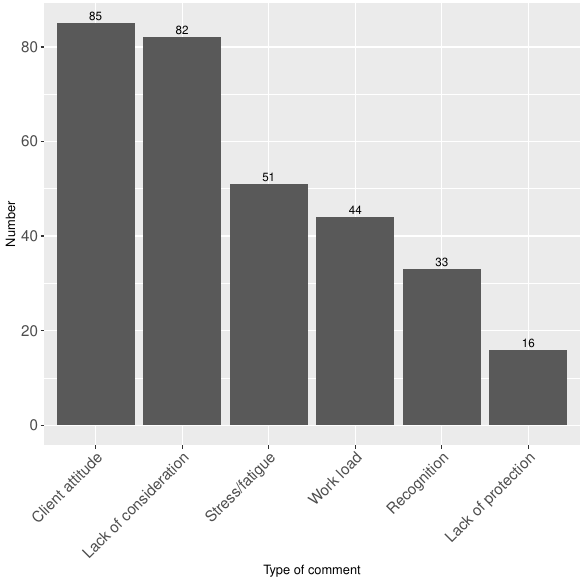
Figure 4. Analysis of free comments by employees ( n = 311 available comments).